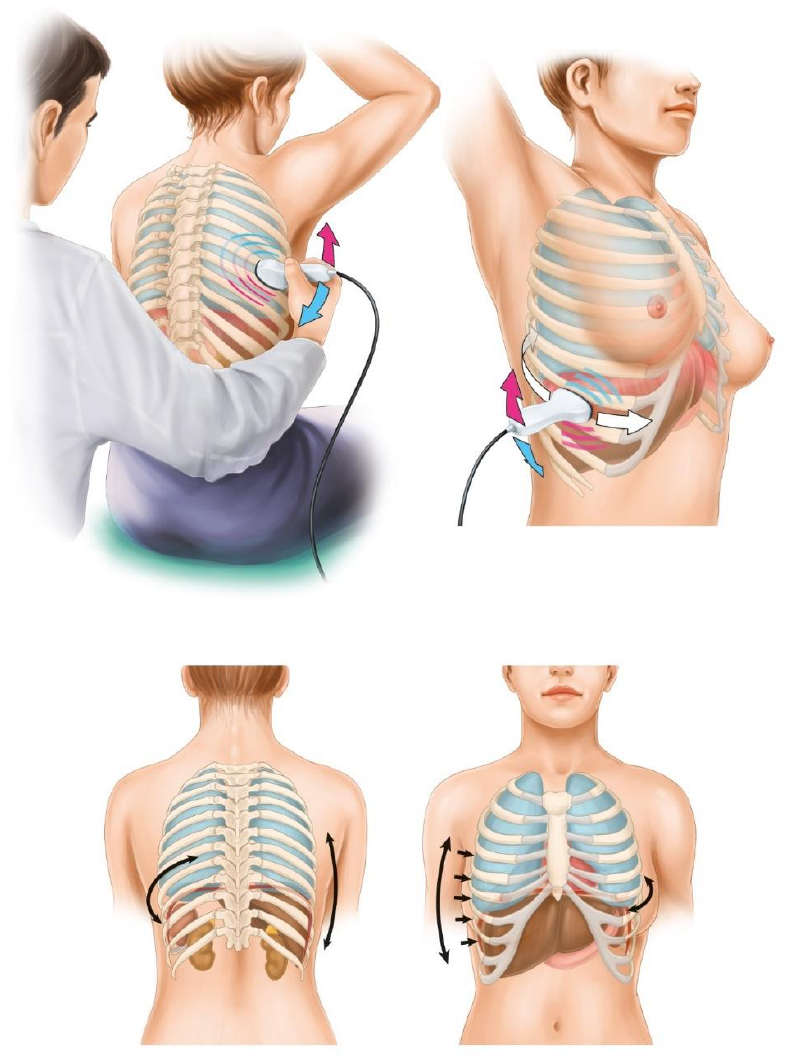
Figure 1. An illustration showing the technique of the lung and intercostal upper abdomen ultrasound examination (arrows indicate directions of probe application).